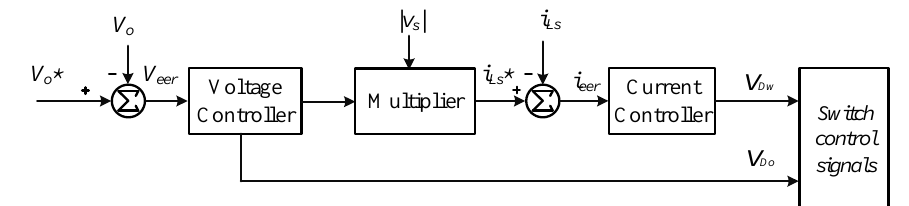
Figure 12. Proposed modified dual loop control